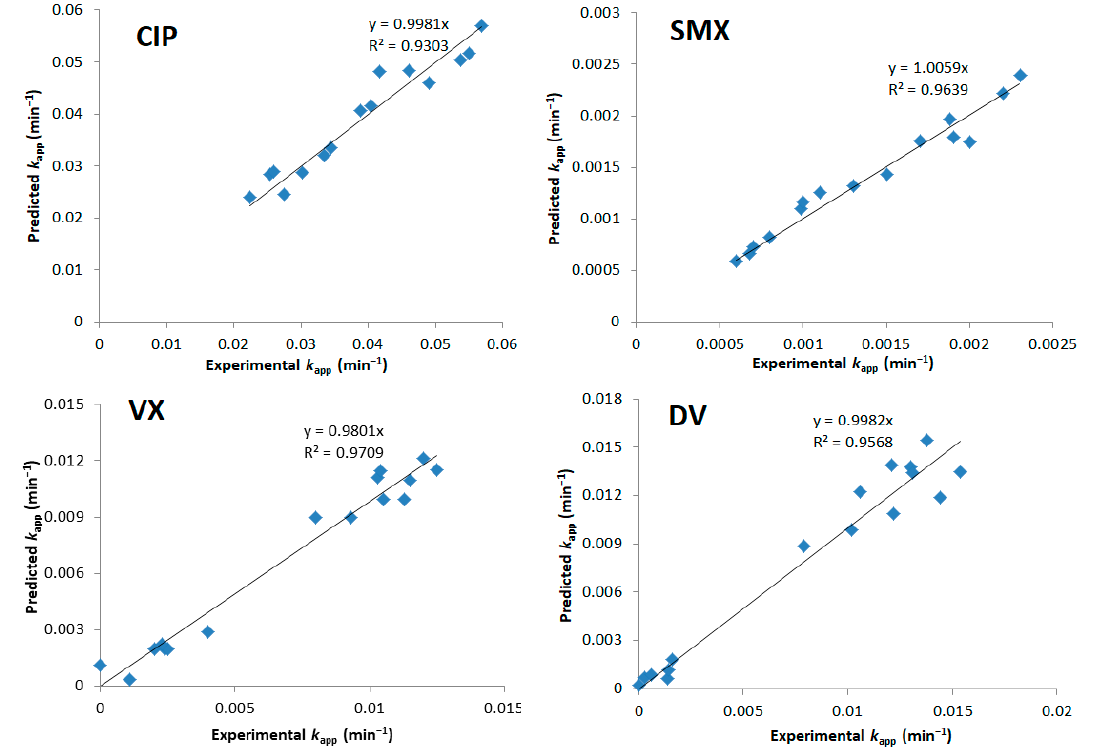
Figure 9. Predicted vs. experimental k app for CIP, SMX, VX, and DV (continuous surface DoE). Surface graphs for CIP, SMX, VX, and DV are shown in Figure 10. High F -values